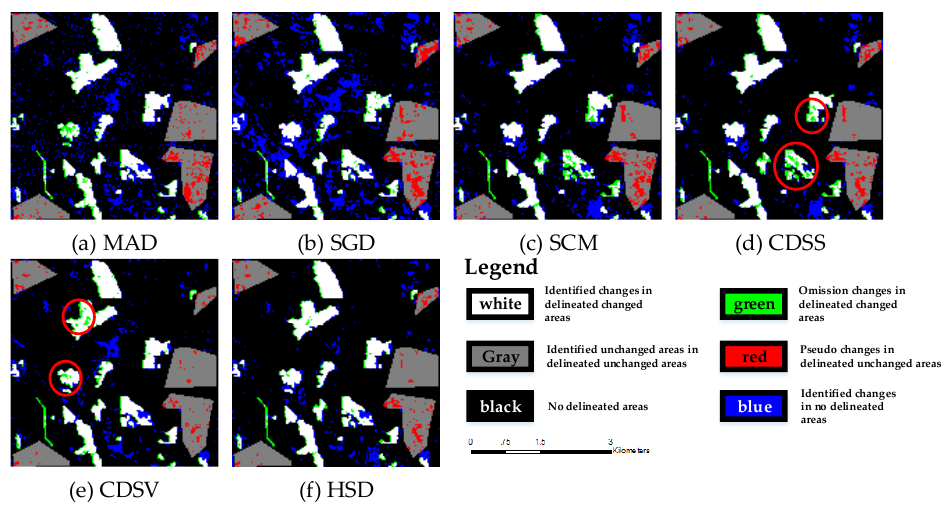
Figure 8. Change maps produced by different algorithms of patch 2.